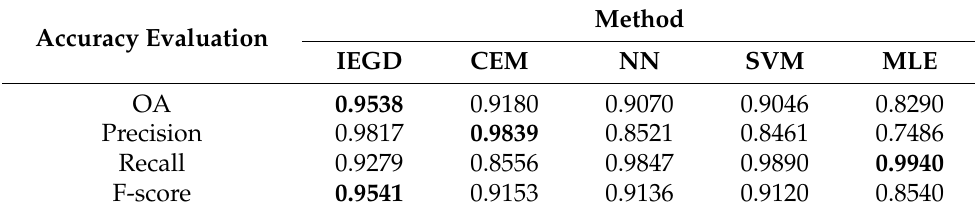
Table 2. Comparison of the accuracy evaluation index of various methods in raft farming areas, where OA denotes the ratio of the predicted correct result samples to the total samples, precision denotes the ratio of the actual positive samples to the predicted positive samples, recall denotes the ratio of the predicted positive samples to the actual positive samples, and the F-score is a combined consideration of the precision and recall.